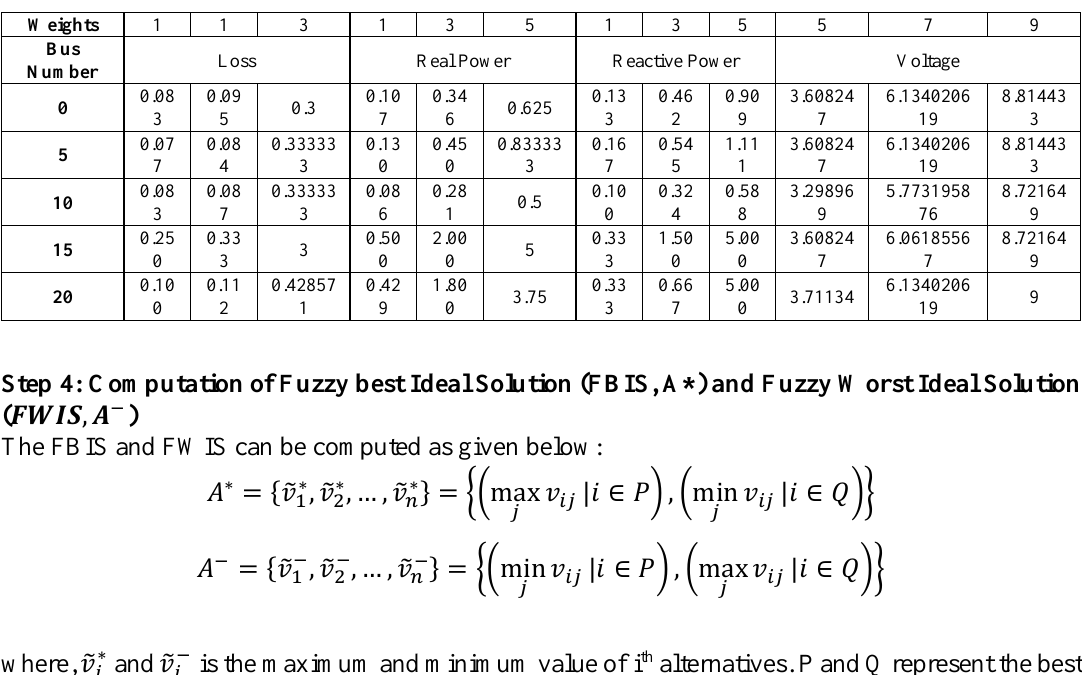
Table 11. Weighted normalized fuzzy decision